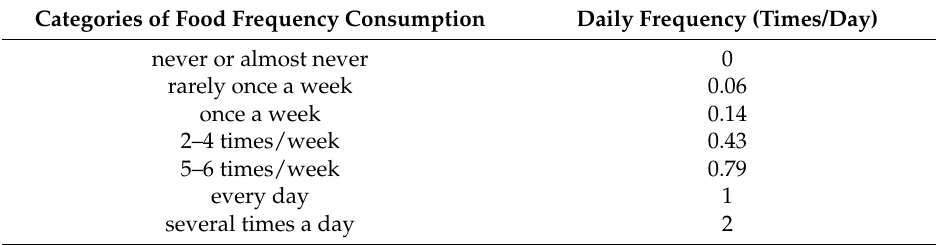
Table 3. Converting categories of food frequency consumption into daily